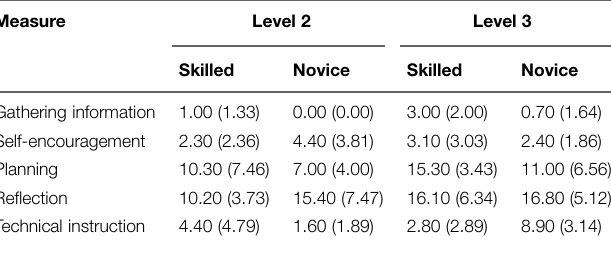
TABLE 4 | Mean and (SD) frequency of verbalization of each data theme during test performance as a function of skill and condition.